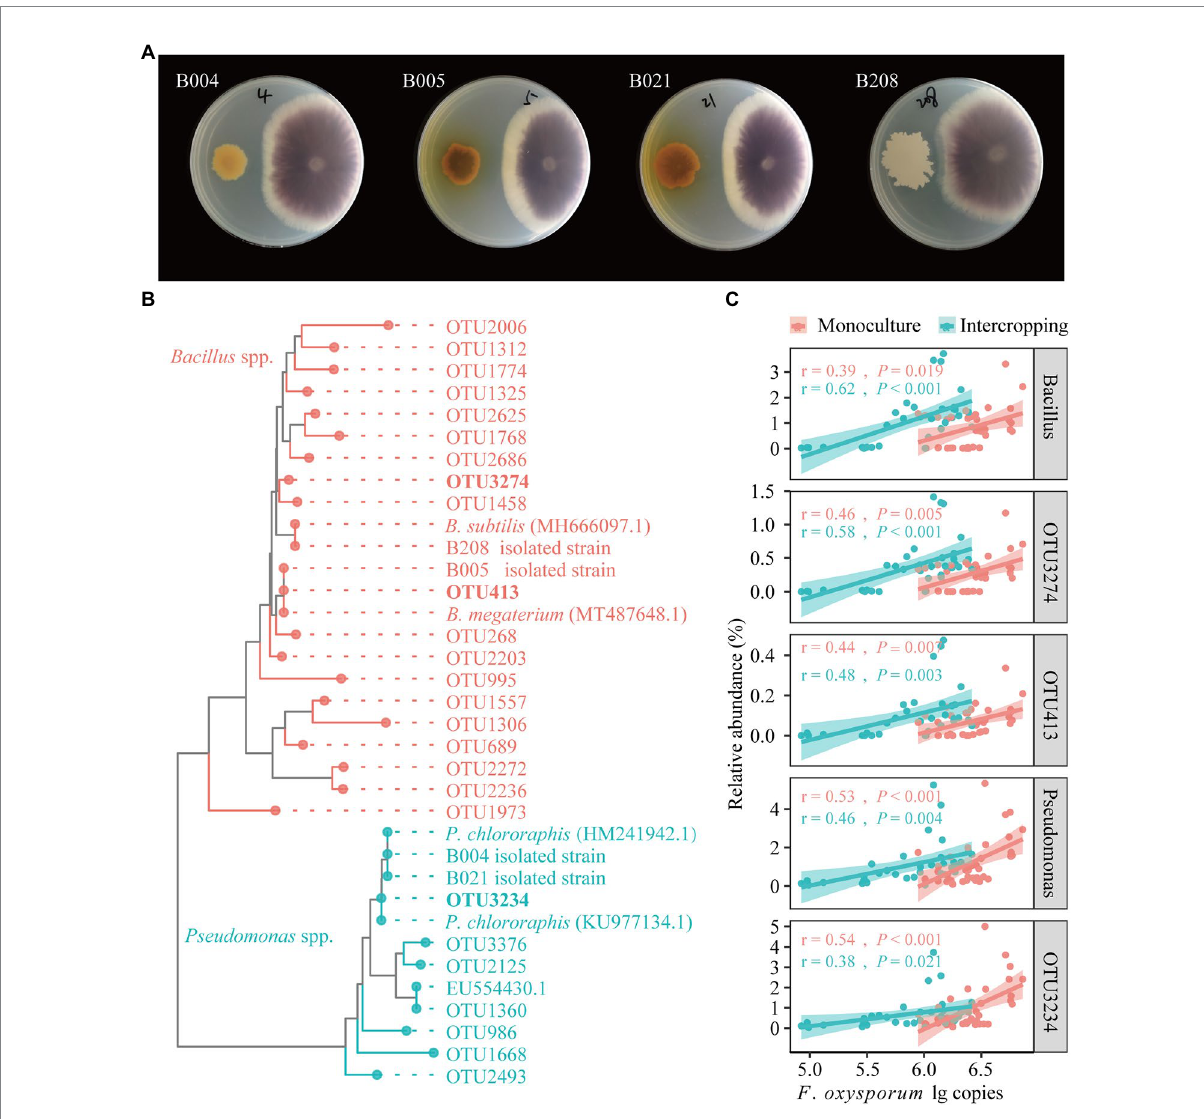
FIGURE 5 Dual culture assays for in vitro inhibition of FOF growth by bacterial isolates (A) . Neighbor-joining (NJ) phylogenetic tree shows the four isolates B004, B021, B005 and B208 with representative sequences selected from GenBank (bold text) and representative sequences of OTUs affiliated with Bacillus and Pseudomonas (B) . Correlations between the relative abundances of the antagonistic OTUs, Bacillus and Pseudomonas with the gene copies of F. oxysporum across all samples (C)